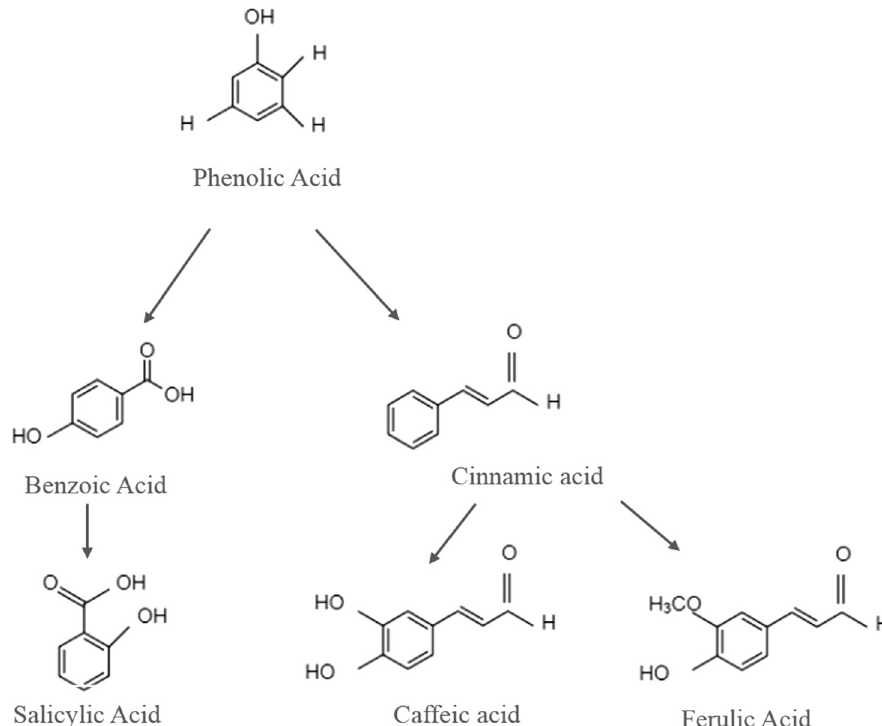
Figure 4: Phenolic acid derivatives that exhibit